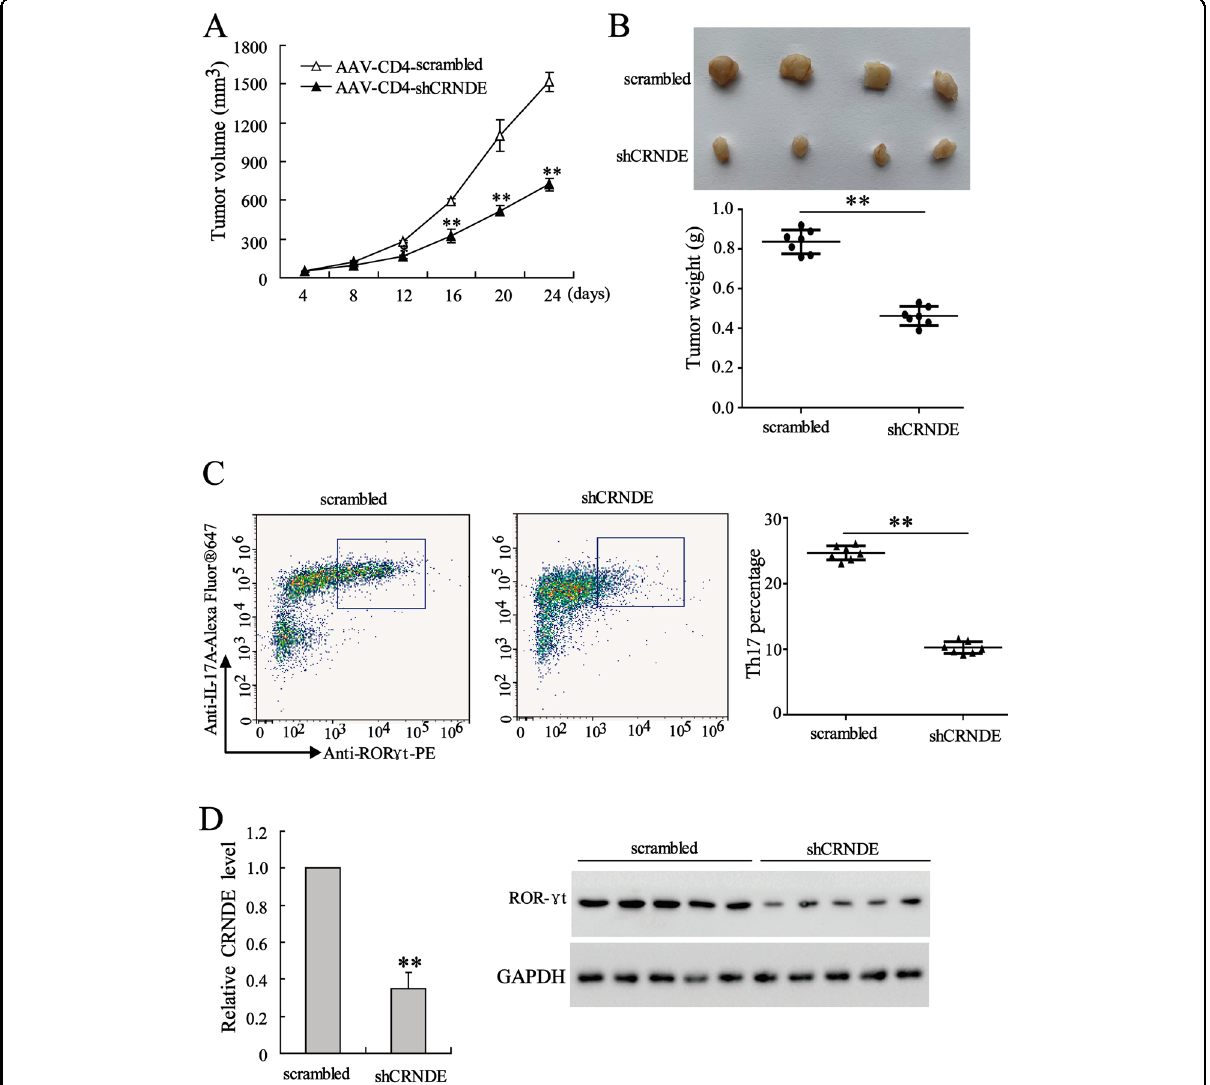
Fig. 7 The silence of CRNDE-h in CD4 + T cells inhibited the CRC tumor growth in mice. The 8-week old male C57BL/6 mice were used to establish a tumor graft model by subcutaneous implantation of 0.2 mL CT-26 cells (5 × 10 6 cells/mL). From the second week after implantation, mice received an intratumoral injection injected of AAV-CD4-shCRNDE-h or AAV-CD4-scrambled every week. Twenty-four days after injection, mice were sacri fi ced. A The tumor volumes were detected every four days. B The images and weights of dissected tumors. C The proportion of Th17 cells in the tumor-in fi ltrating T cells. D The expressions of CRNDE-h and ROR γ t in tumor-in fi ltrating T cells were detected by western blot and qRT-PCR. ** p < 0.01 vs.